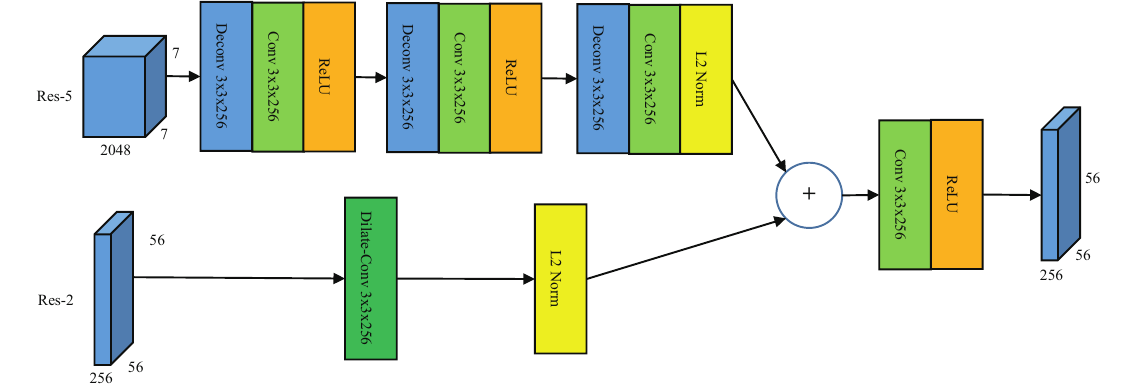
Figure 3. The structure of Multilayer fusion.